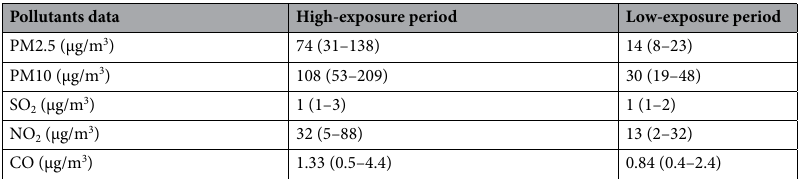
Table 1. Pollutants data between high-exposure period and low-exposure period. CO carbon monoxide, NO 2 nitrogen dioxide, PM particulate matter, SO 2 sulfer